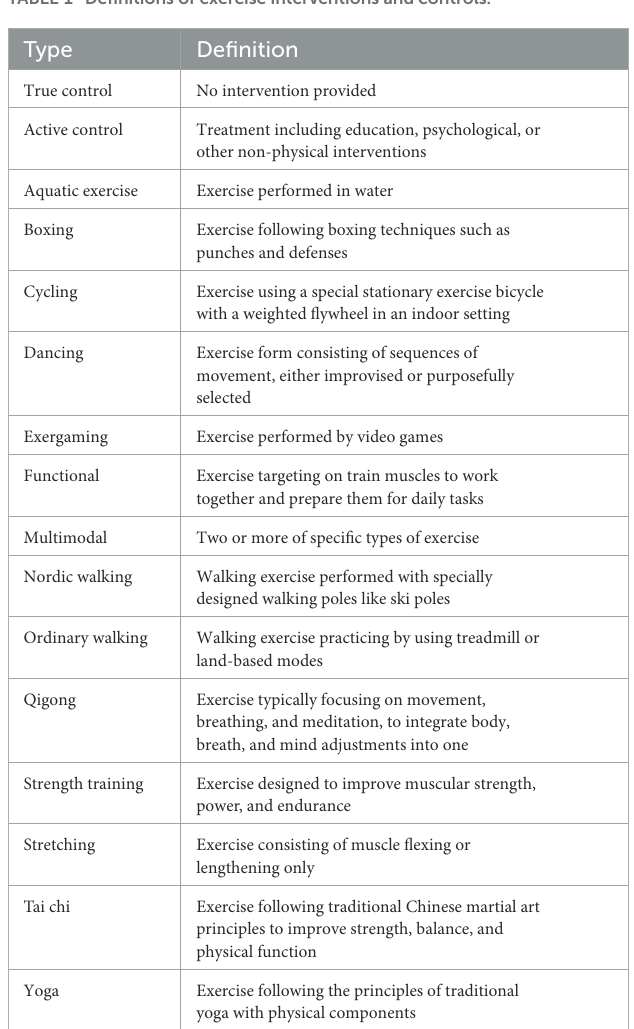
TABLE 1 Definitions of exercise interventions and